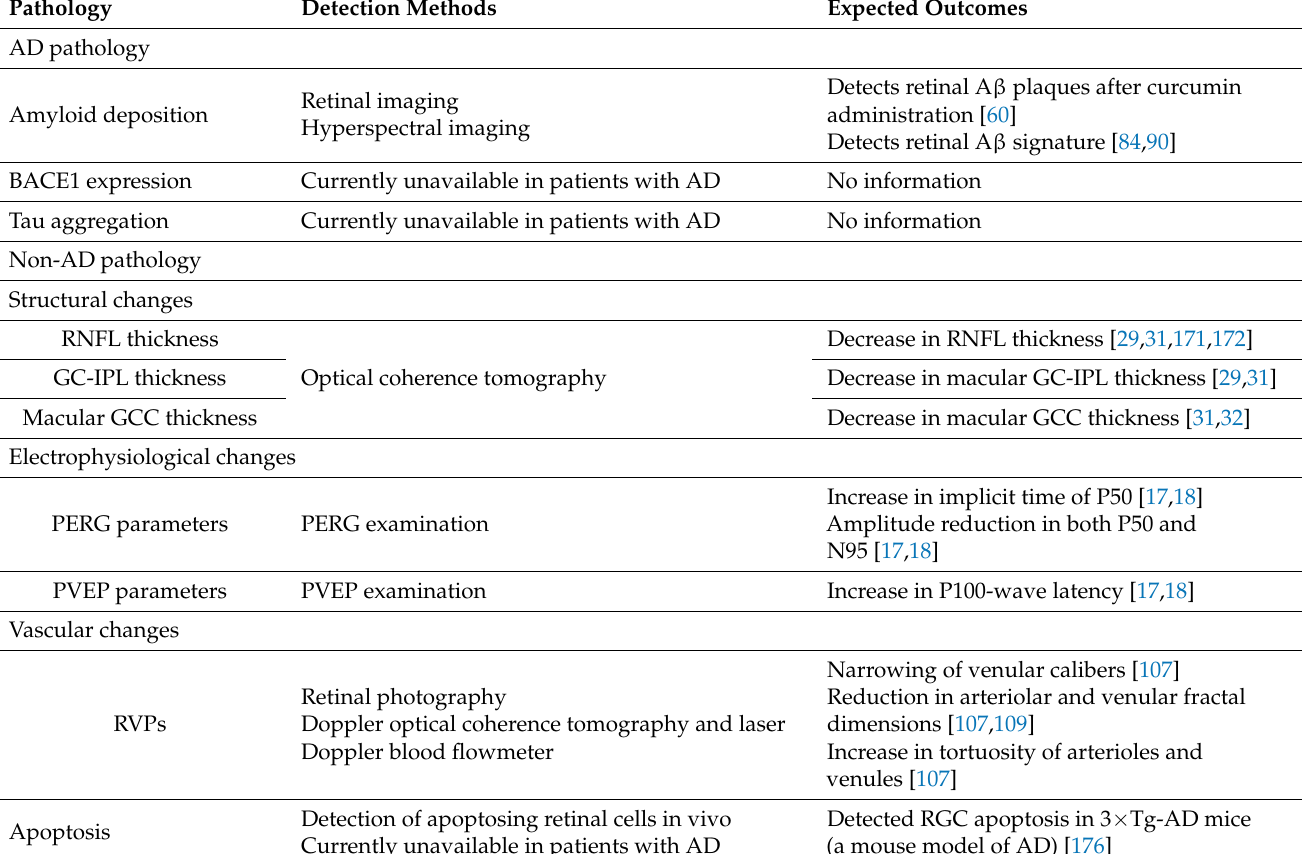
Table 4. Potential retinal biomarkers for Alzheimer’s disease.